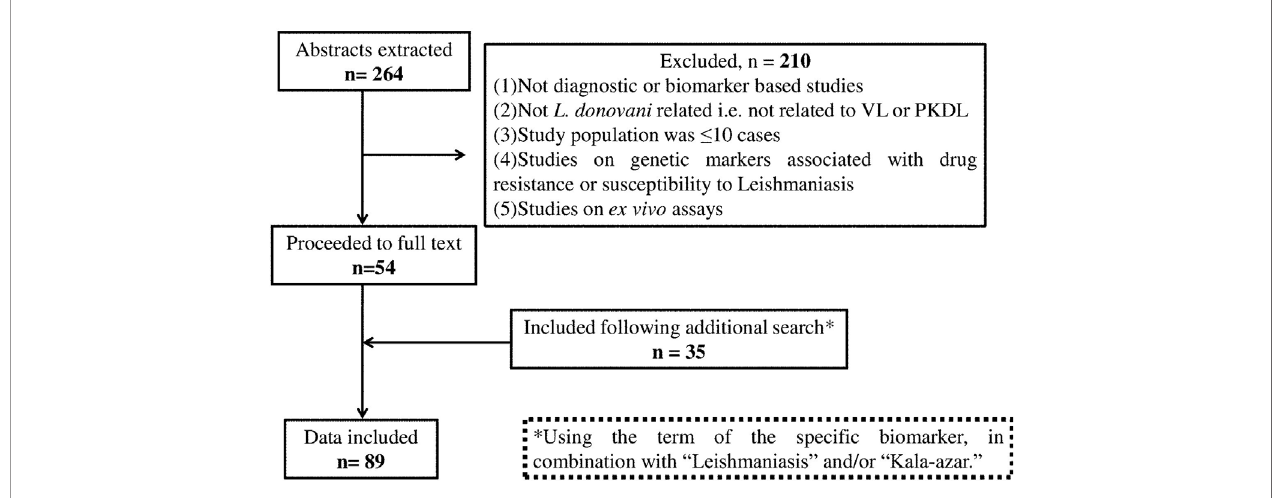
FIGURE 1 | Flow diagram of the studies